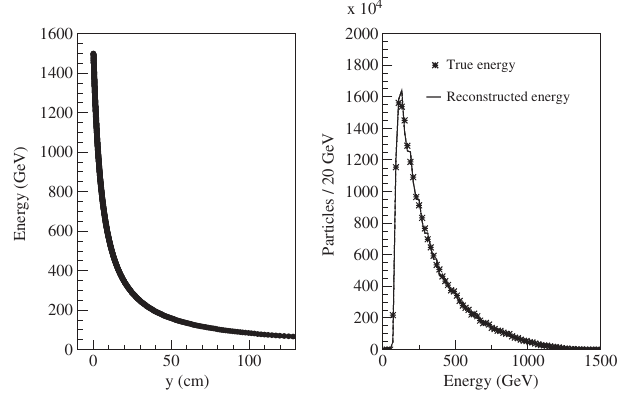
FIG. 11. Reconstructing the energy spectrum of the coherent pairs from the vertical beam profile of the wrong-sign charged particles just after the separation region.